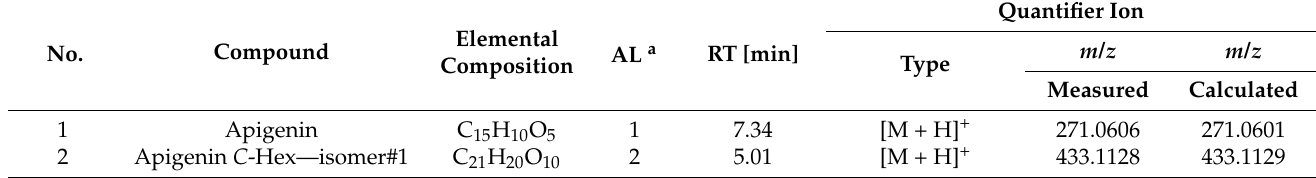
Table 2. Annotated metabolites detected in hydroethanolic leaf extracts of Z. multiflora , Konar Siah population. For tandem mass spectral data and further information on annotation, see Supplemen- tary Table S1.